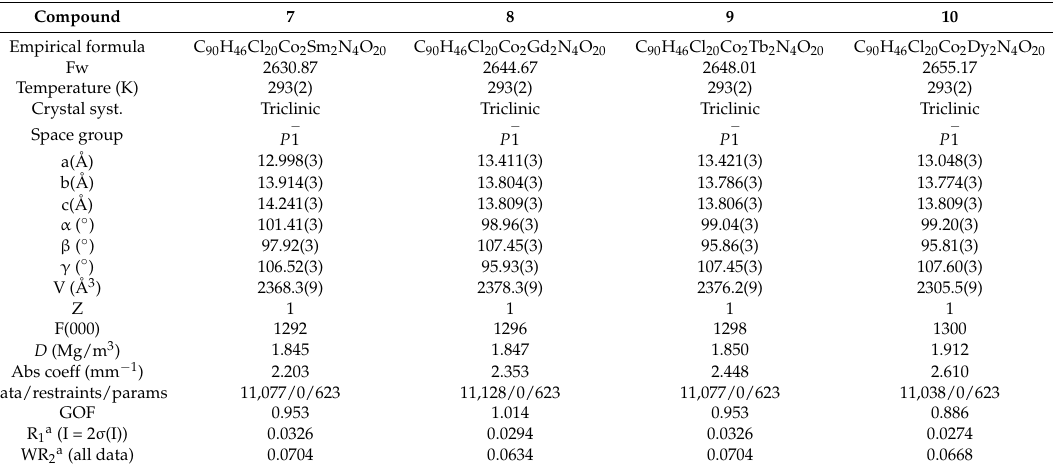
Table 3. Crystal data and structure refinement information for